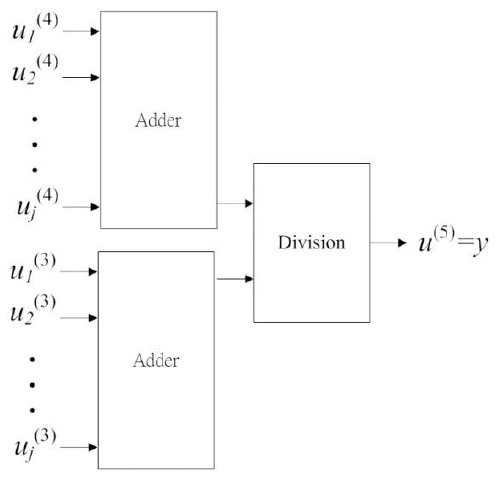
Figure 21. Output defuzzifier module.